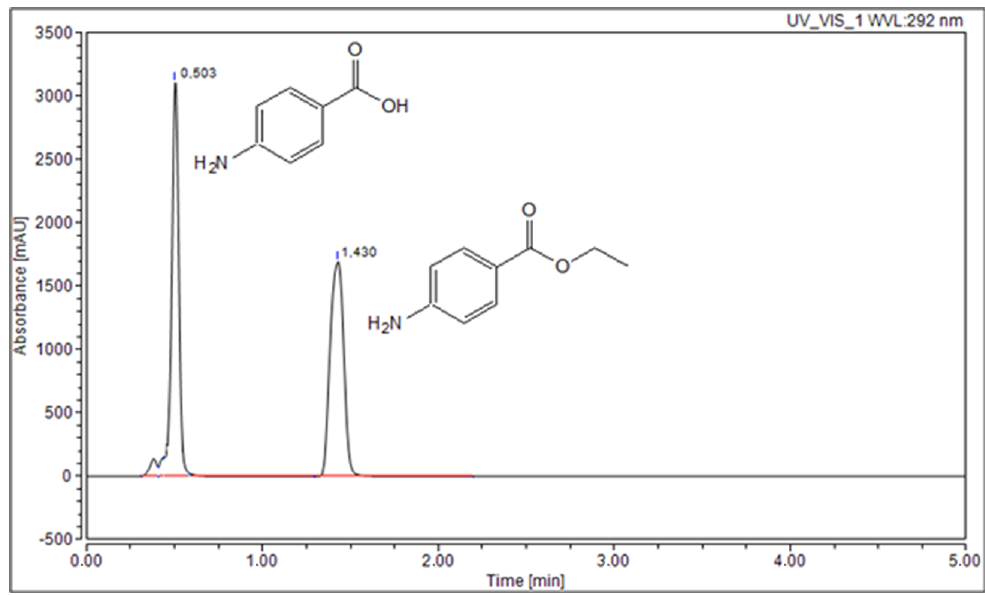
Figure 3. HPLC chromatogram of benzocaine in the presence of its main impurity ( p -aminobenzoic